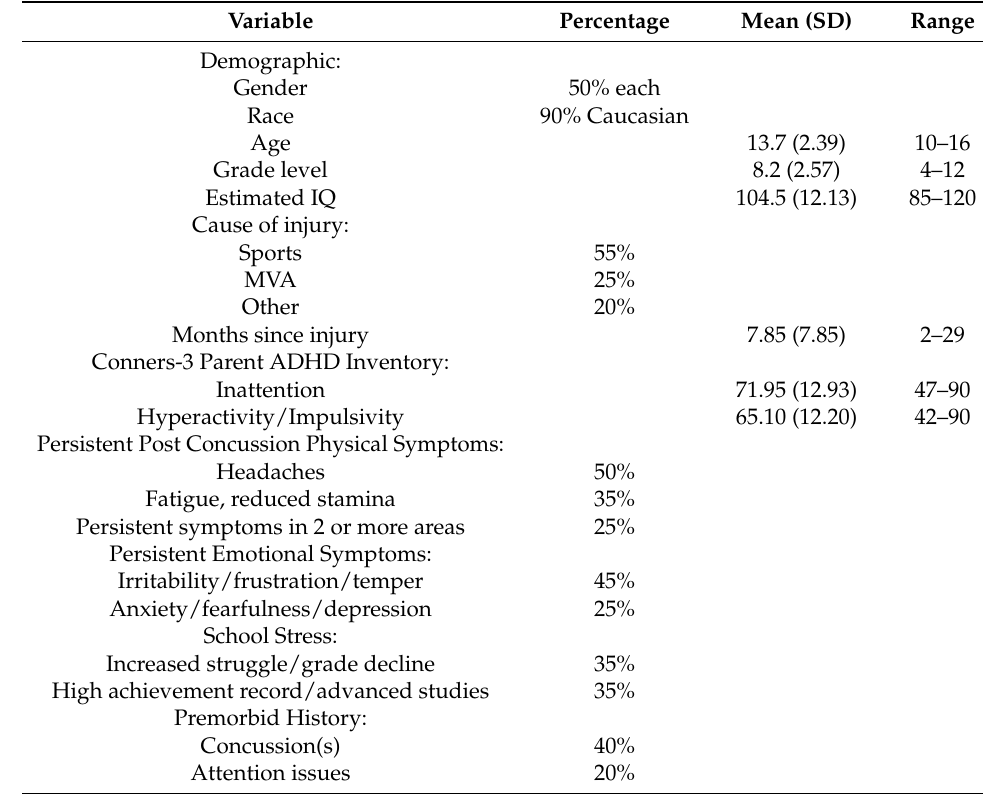
Table 1. Demographic and clinical information at